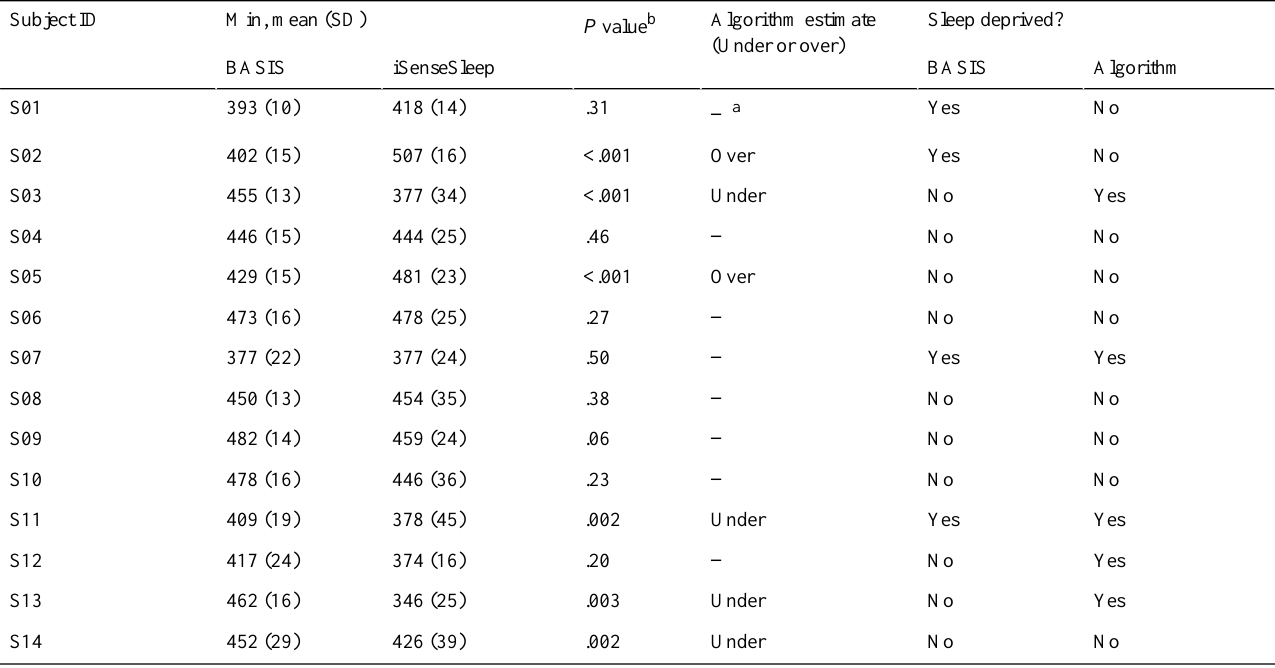
Table 4. Average sleep duration by the BASIS smartwatch versus iSenseSleep algorithm, and statistical significance tests.